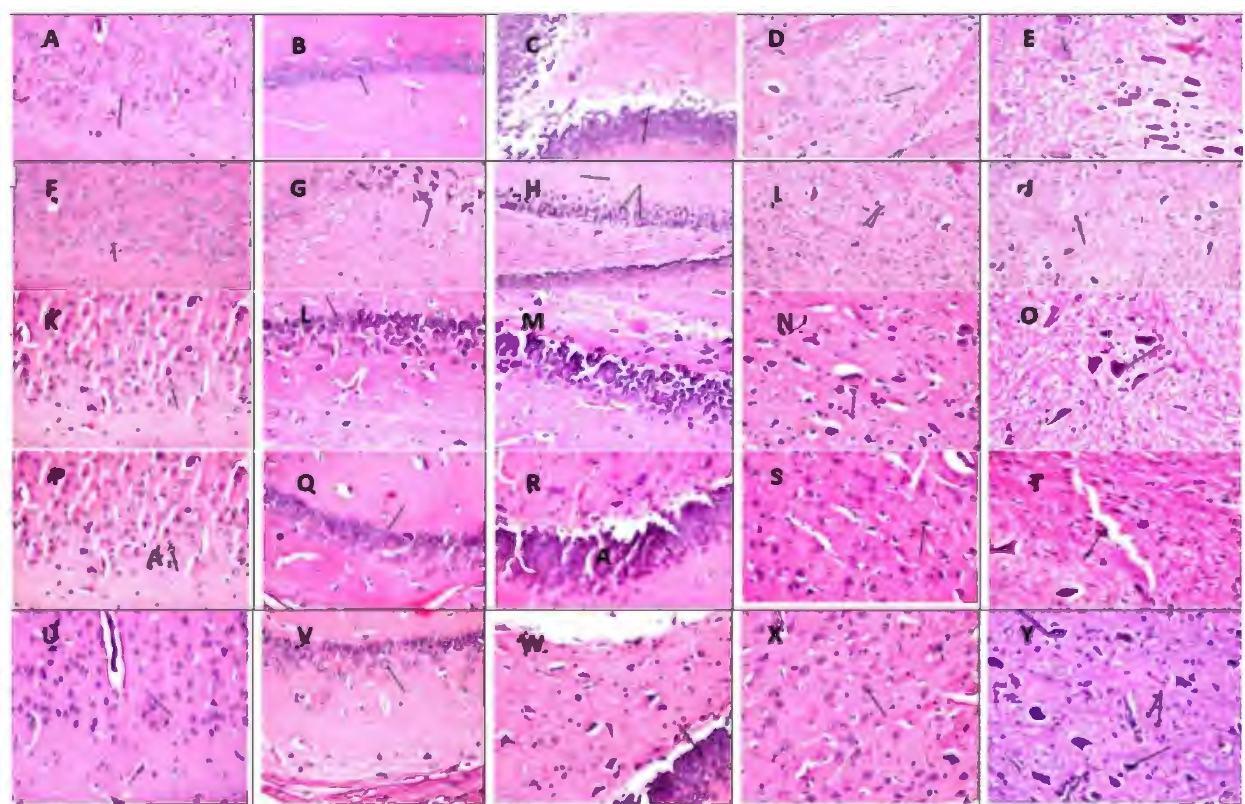
Figure 4. Photomicrographs of brain tissue specimens stained by H & E ( × 40). Photomicrographs ( A – E ): Transverse brain tissue sections from the control group showing no histopathological alteration in the cerebral cortex, hippocampus, striatum, or substantia nigra. Photomicrographs ( F – J ): Transverse brain tissue sections from AlCl 3 -treated animals showing no histopathological alteration in the cerebral cortex ( F ). The pyramidal cells in the hippocampus showed nuclear pyknosis and degeneration as well as in the fascia dentate, while the neurons in the subiculum were intact ( G , H ). There was congestion in the blood vessels of the striatum ( I ). Atrophy was detected in some of the neurons in substantia nigra ( J ) (arrows). Photomicrographs ( K – O ): The transverse brain tissue section from the fluoxetine-treated animals shows nuclear pyknosis and degeneration in most cerebral cortex neurons ( K ). The subiculum in the hippocampus was intact ( L ), while the fascia dentate showed nuclear pyknosis in a few neuronal cells ( M ) and gliosis in the striatum ( N ). There was no histopathological alteration in the substantia nigra ( O ) (arrows). Photomicrographs ( P – T ): Transverse brain tissue section from the wheatgrass group showing nuclear pyknosis in some few neurons at the cerebral cortex ( P ). The subiculum in the hippocampus showed typical histological structure ( Q ), while the fascia dentate had nuclear pyknosis in a few neurons ( R ). Diffuse gliosis was detected in the striatum ( S ), while the substantia nigra was intact ( T ) (arrows). Photomicrographs ( U – Y ): Transverse brain tissue section from the combination group showing cerebral cortex and subiculum in the hippocampus with typical histological structure, while the fascia dentata showed nuclear pyknosis in few neurons ( U – W ). Diffuse gliosis was detected in the striatum ( X ), as well as substantia nigra ( Y )